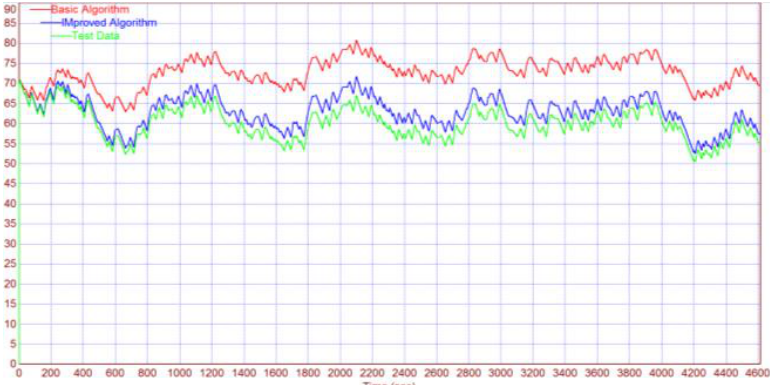
Figure 15. Comparison of different algorithms of temperature rise versus measured temperature results [91].